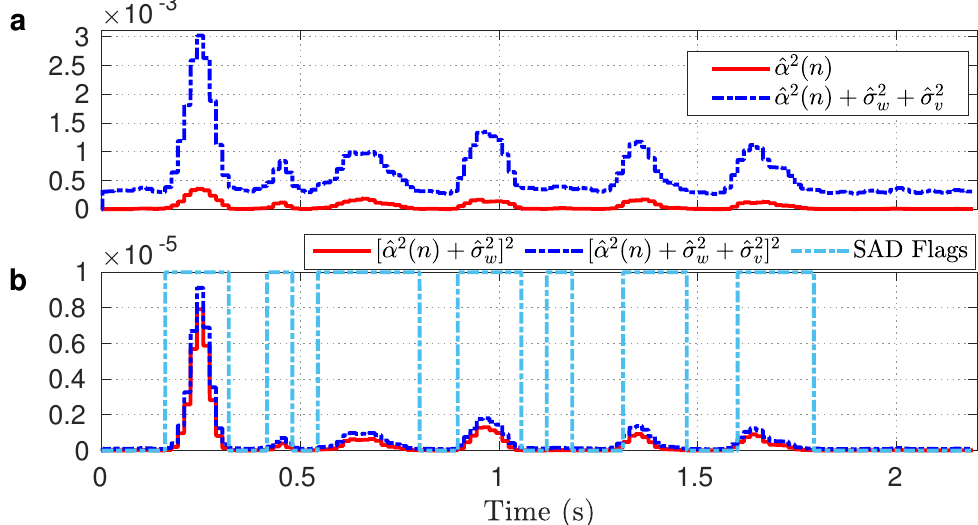
[ ˆ α 2 ( n ) + ˆ σ 2 + ˆ σ 2 ] 2 and w v , and ( b ) w